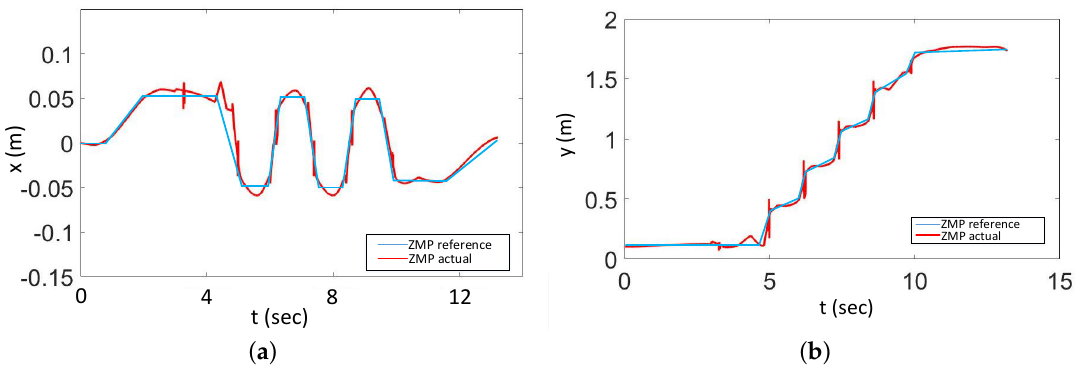
Figure 18. ZMP reference vs. actual with proposed method ( a ): Lateral ZMP, ( b ): Longitudinal zero moment point (ZMP).